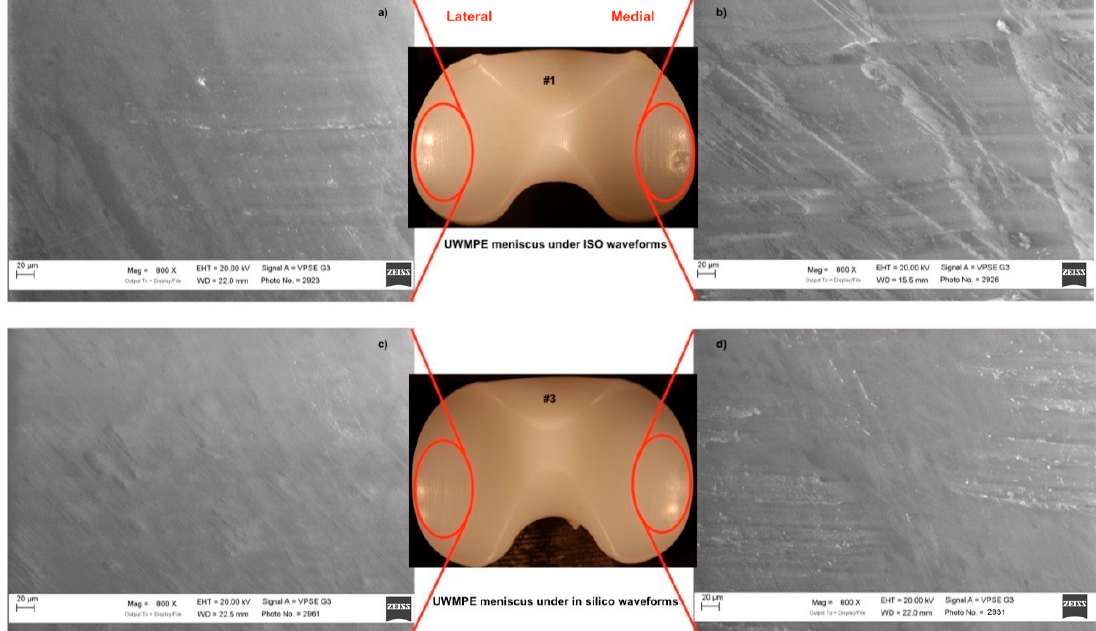
The worn UHMWPE inserts deriving from the ISO and multibody simulation were analyzed in 223